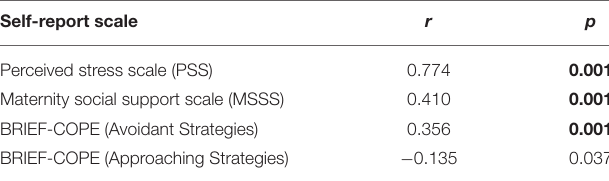
Bold values indicates the significant